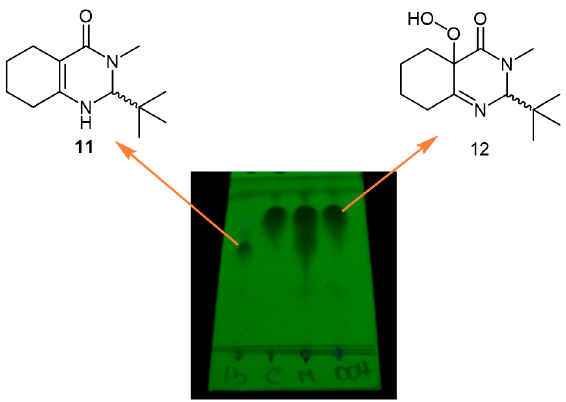
Figure 4. Thin layer chromatography (hexane:AcOEt, 6:4) for (1b) without oxygen, (C) with oxygen